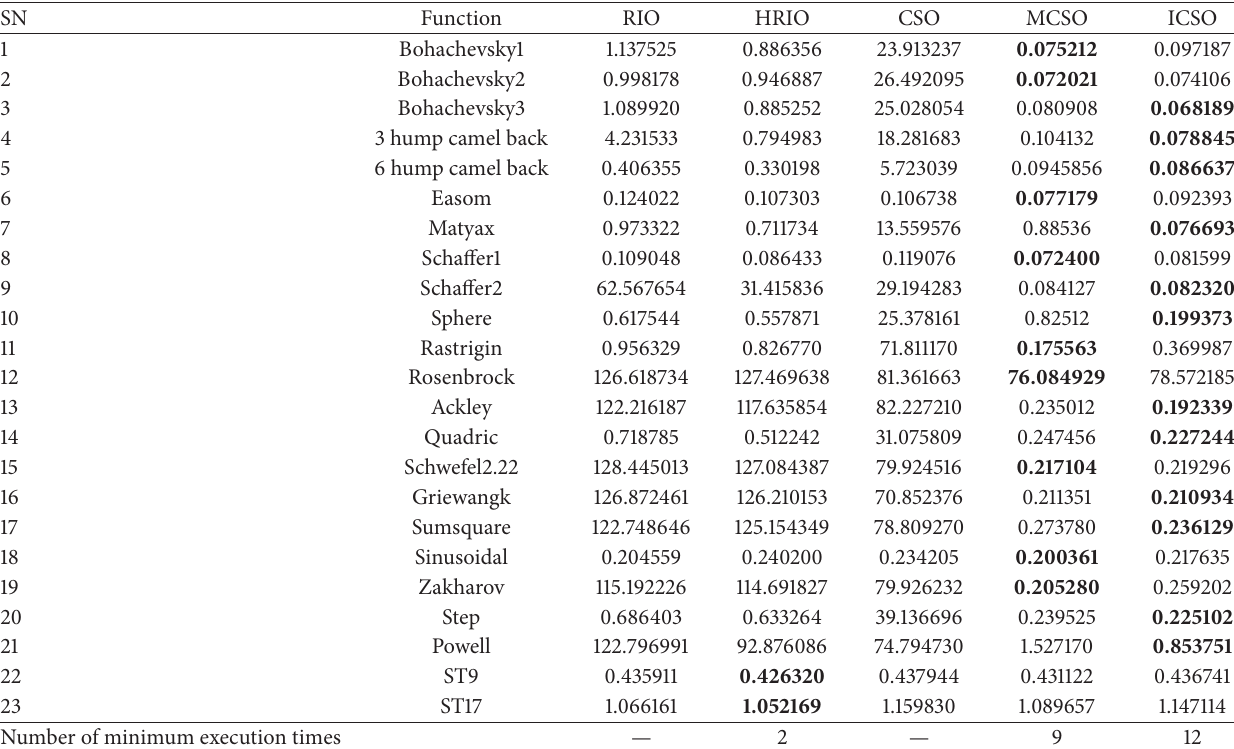
Table 9: Comparison of exec1ution time of RIO, HRIO, CSO, MCSO, and